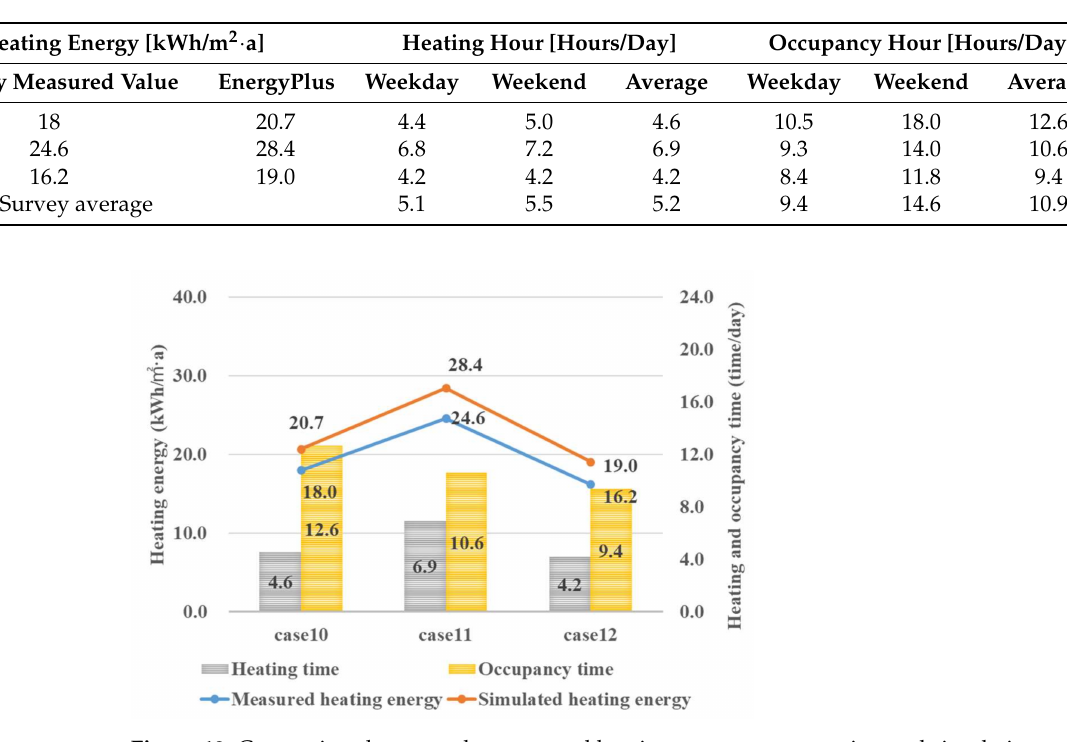
Table 15. Survey results of heating energy, heating hour, and occupancy hour (Case 10-12).